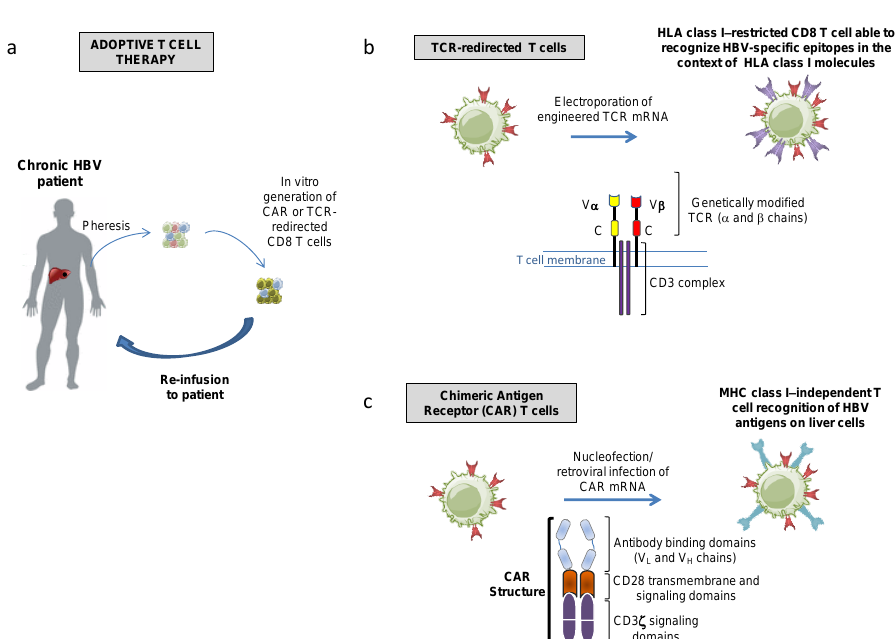
Figure 2. Gene transfer-based strategies as new tools for immune therapy in hepatic tumors and chronic HBV infections. ( a ) Patient-derived CD8 T cells can be modified to express antitumor / antiviral T cell receptors (TCRs) or chimeric antigen receptors (CARs). The infusion of genetically modified T cells targeting specific peptide / HLA complexes or non-processed antigens on the surface of the infected liver cells provides the immune system with functionally e ffi cient CD8 T cells of the desired specificity. ( b ) Schematic representation of an engineered CD8 T-cell with re-directed specificity against a specific HBV epitope. T cells are purified from chronic patients, engineered by electroporation of HBV-specific TCR-expressing vectors and reinfused in the patient. Modified α and β chains of the TCR complex allow high a ffi nity recognition of HLA class I dependent viral or tumor epitopes to reconstitute functional specific immunity. ( c ) CAR T cell engineering is based on the transduction of autologous T cells with an expression vector coding for a chimeric antigen receptor, consisting of an antibody binding fragment (that allows for recognition of conformational antigens, such as HBsAg expressed on the hepatocyte membrane), fused with CD28 transmembrane and CD3zeta intracellular domains, which can mediate constitutive signaling leading to e ff ector T cell activation and HLA class I independent antigen